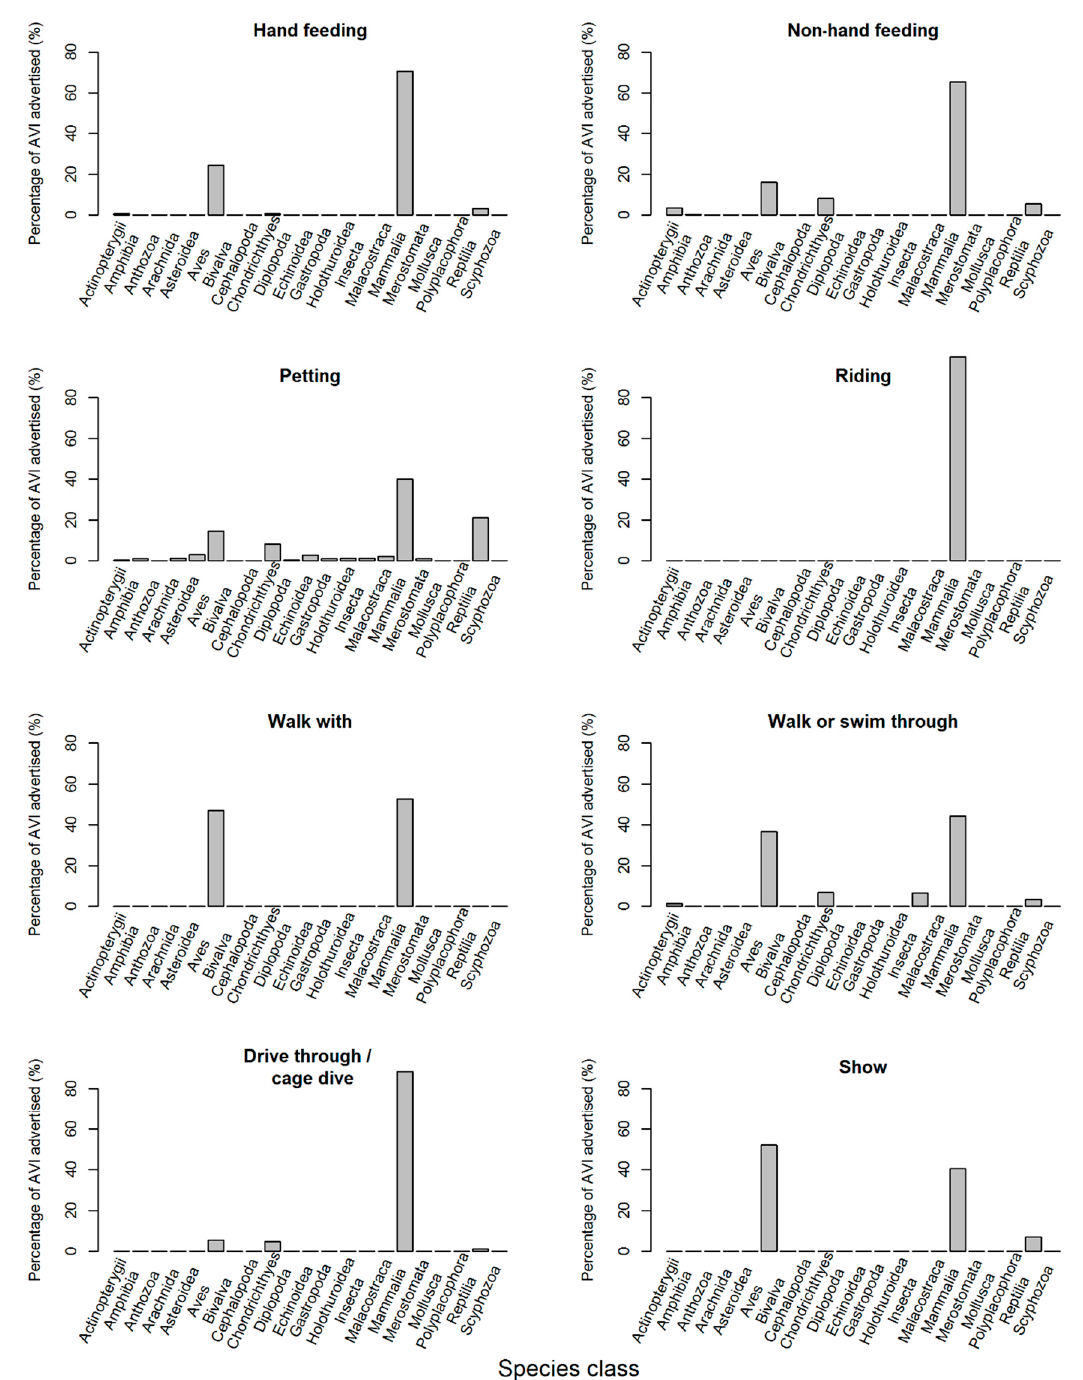
Figure 8. Percentage of advertised AVIs advertised per species class split by AVI type. A significant di ff erence between the observed AVI frequency per species class and those expected with an even distribution were found for each AVI type (hand feeding: χ 2 = 5845, df = 20, p < 0.001; non-hand feeding: χ 2 = 4641, df = 20, p < 0.001; petting: χ 2 = 5602, df = 20, p < 0.001; riding: χ 2 = 1340, df = 20, p < 0.001; walk with: χ 2 = 686, df = 20, p < 0.001; walk or swim through: χ 2 = 5953, df = 20, p < 0.001; drive through or cage dive: χ 2 = 6810, df = 20, p < 0.001; show: χ 2 = 6984, df = 20, p < 0.001). p -values were adjusted for multiple comparisons.